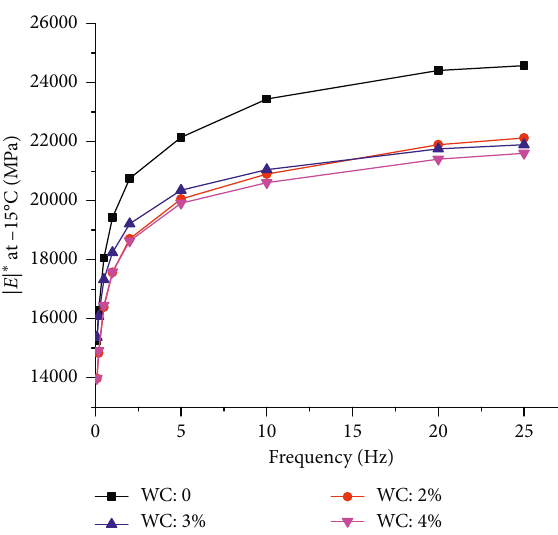
Figure 10: 90#AC-20-type normal-temperature dynamic